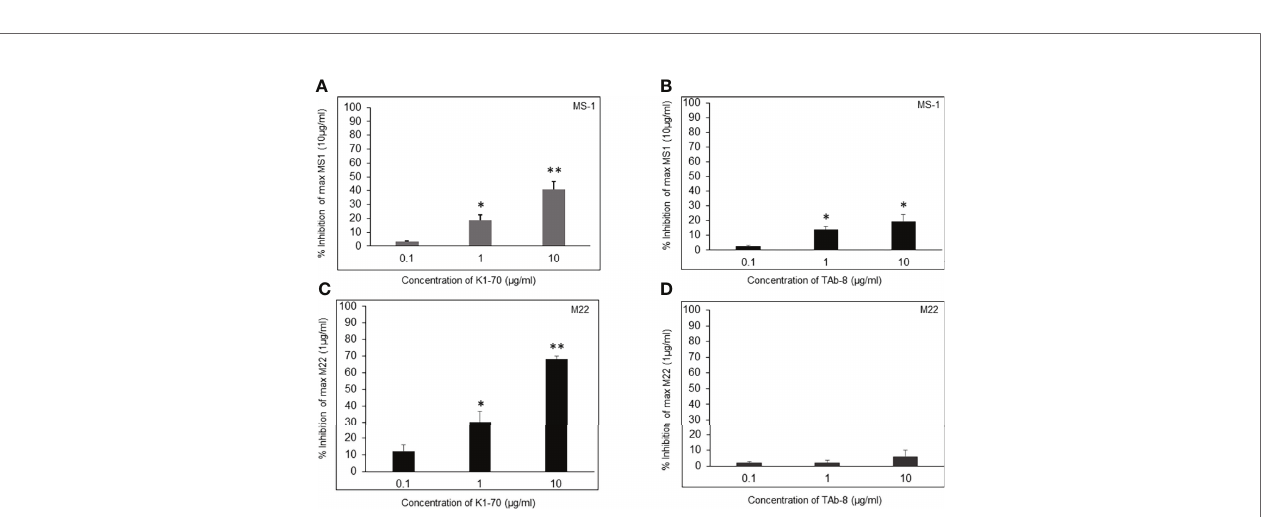
plotted as % inhibition on the y- axis. The presence of strong blocking antibody caused >40% inhibition whereas in the presence of the weaker blocking antibody the inhibition was <15%. (C, D) Here the inhibition measurements were assessed in the presence of the potent stimulating mAb (M22). As shown, much greater inhibition